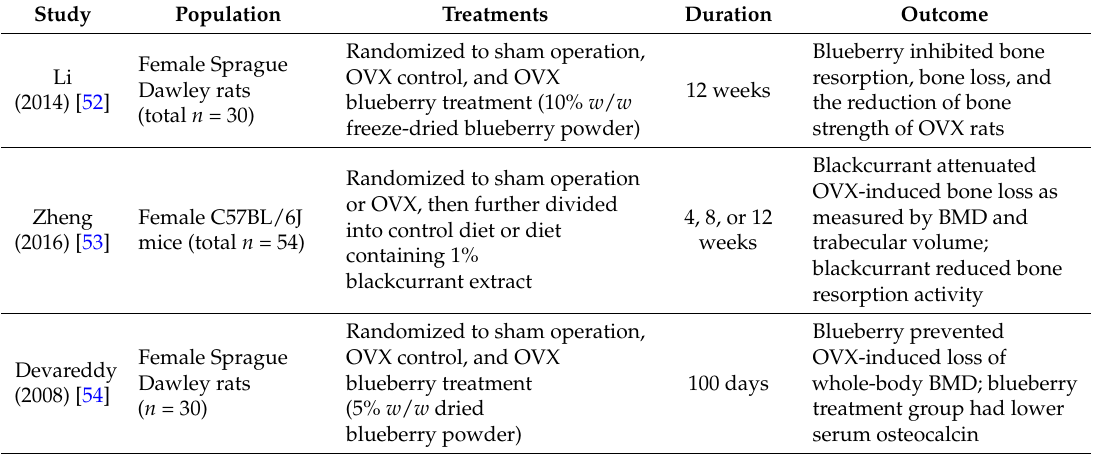
Table 3. Animal studies of the impact of berry antioxidants on ovariectomy-induced bone